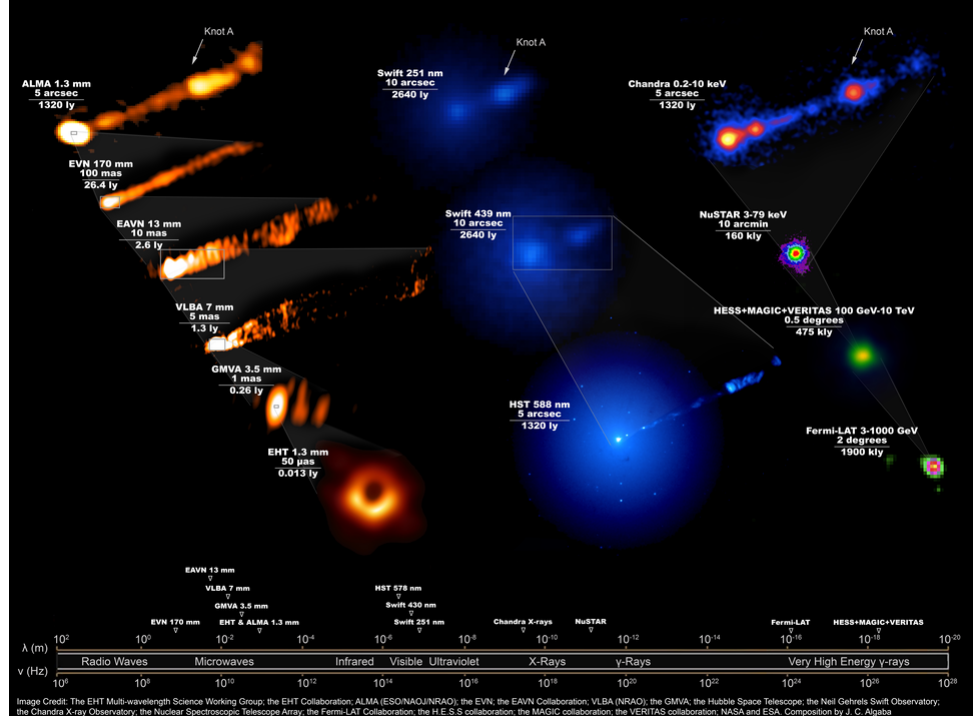
Figure 3. Taken from [107], a composite image of M87 viewed across the broadband spectrum from radio frequencies to γ -ray frequencies. Shown here are the vast range of scales spanned by the AGN’s black hole and its forward-pointing jet. Ground-breaking observations by the EHT has allowed us to image for the first time the SMBH at the heart of M87. In addition, we can see various bright knots or features along the jet, for example Knot A clearly visible with ALMA, Swift, HST, and Chandra. Credit: the EHT Multi-Wavelength Science Working Group; the EHT Collaboration; ALMA (ESO/NAOJ/NRAO); the EVN; the EAVN Collaboration; VLBA (NRAO); the GMVA; the Hubble Space Telescope, the Neil Gehrels Swift Observatory; the Chandra X-ray Observatory; the Nuclear Spectroscopic Telescope Array; the Fermi-LAT Collaboration; the H.E.S.S. collaboration; the MAGIC collaboration; the VERITAS collaboration; NASA and ESA. Composition by J.C.